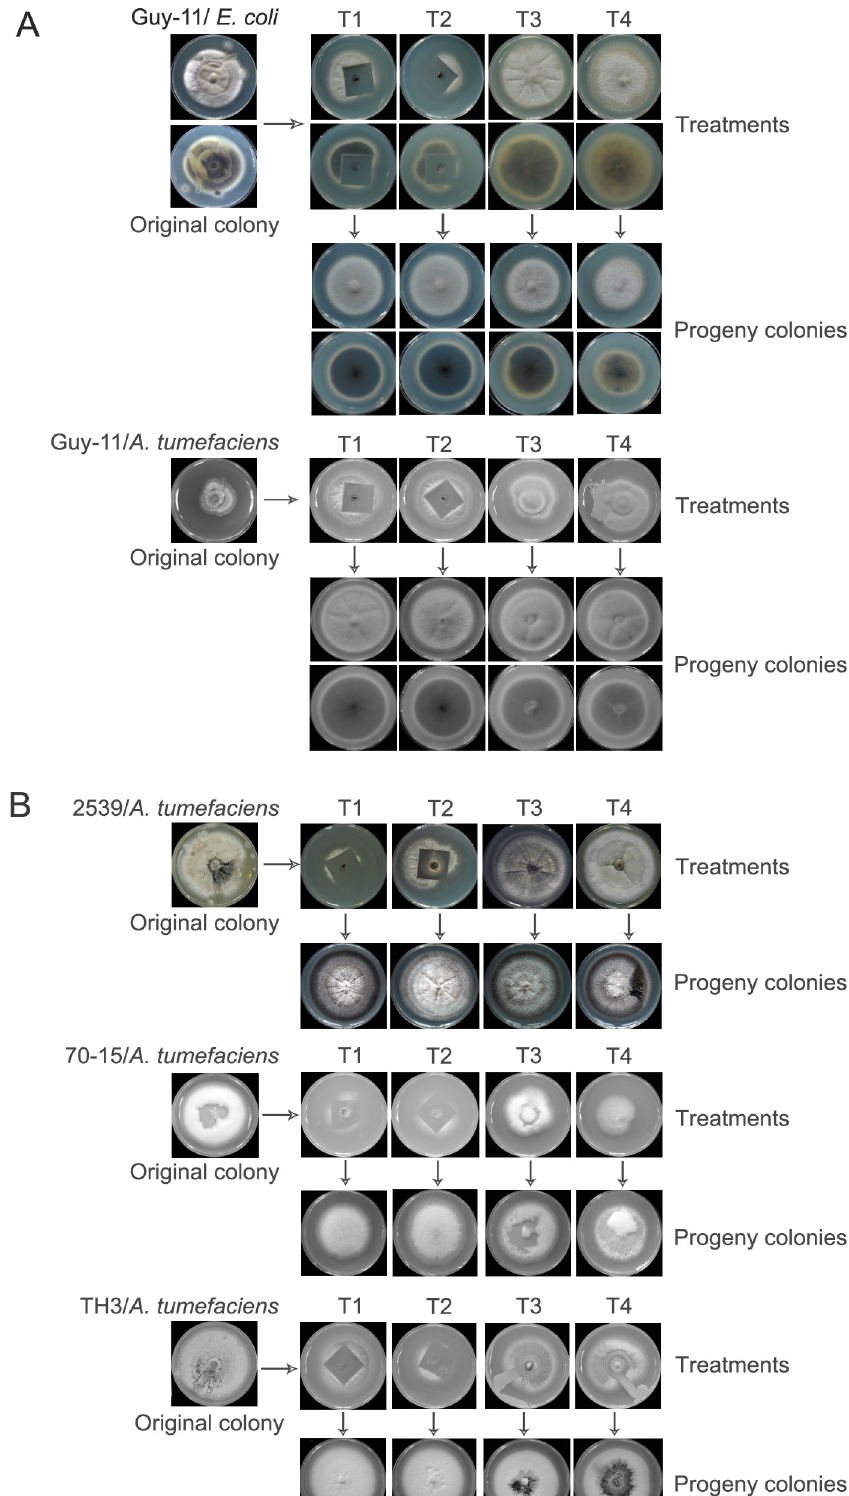
Fig 3. Comparison the treatments basing on CS method and antibiotic inhibitions. (A) M . oryzae Guy-11 strain mixed with E . coli or A . tumefaciens were treated using 4 different methods; (B) The treatments with M . oryzae 2539,